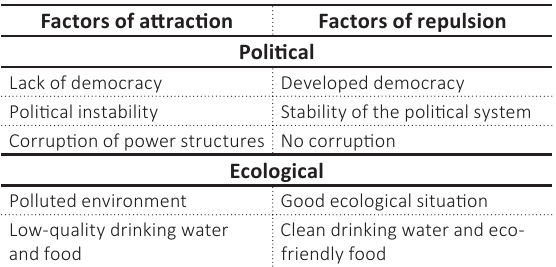
Table 1 (cont.). Key factors of migration